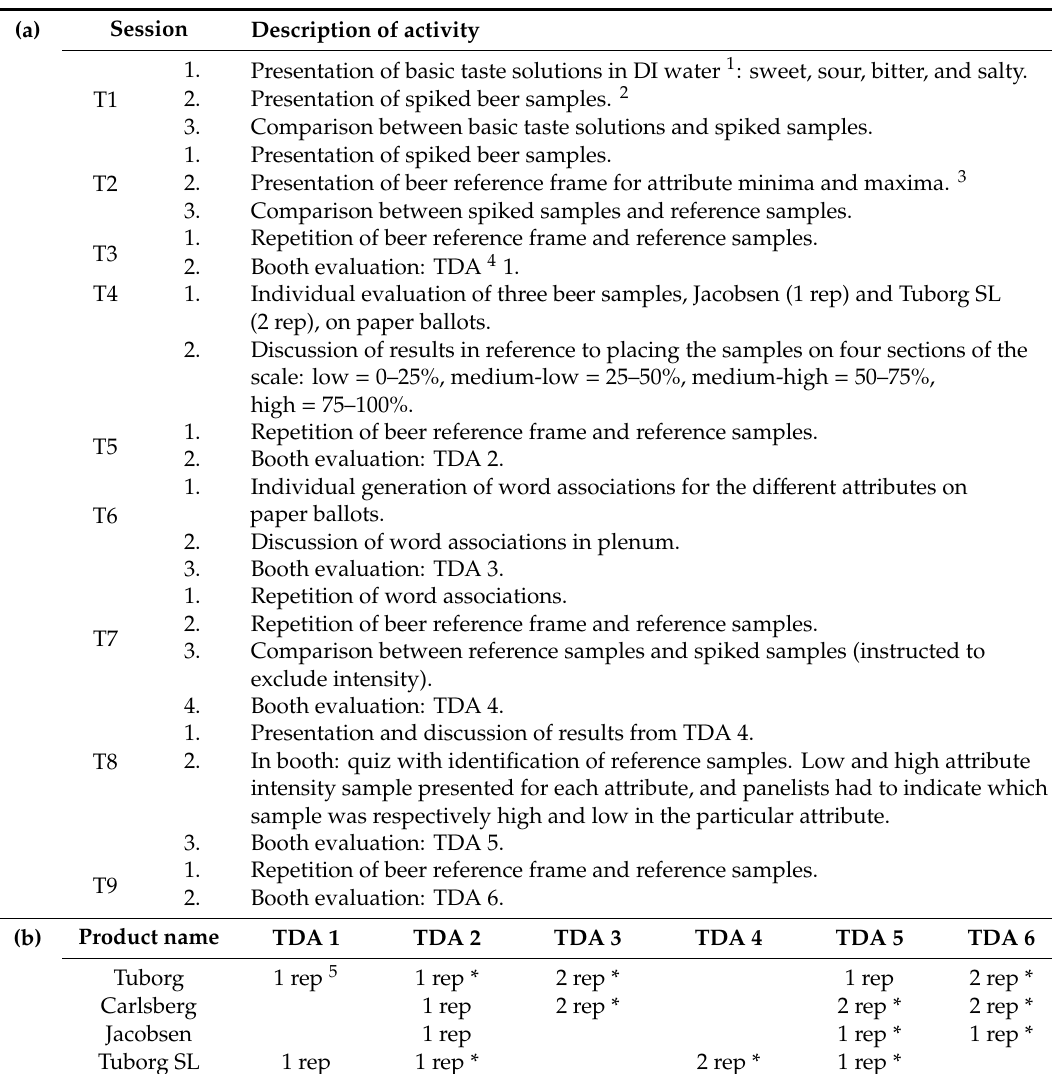
Table 2. ( a ) Overview of activities performed during the di ff erent nine training sessions, T1 to T9. ( b ) Overview of samples included during the training descriptive analysis and application of FCM during these sessions.